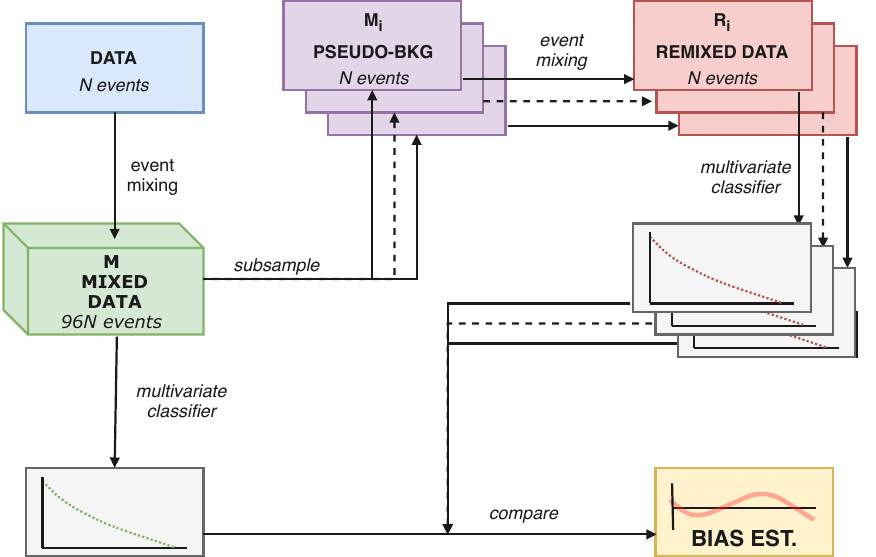
Figure 11 . Diagram describing the procedure used to estimate the background bias correction. All possible combinations of mixed hemispheres except those used for training are added together to create a large sample M of 96 N events from which we repeatedly subsample without replacement 200 replicas M i of N events. The hemisphere mixing procedure is then carried out again for each of this replicas to produce a set of re-mixed data replicas R i . The trained multivariate classi(cid:12)er trained is then evaluated over all the events of M and each R i . and the histograms of the classi(cid:12)er output are compared to obtain a the di(cid:11)erences for each of the replicas. The median di(cid:11)erence is taken as bias